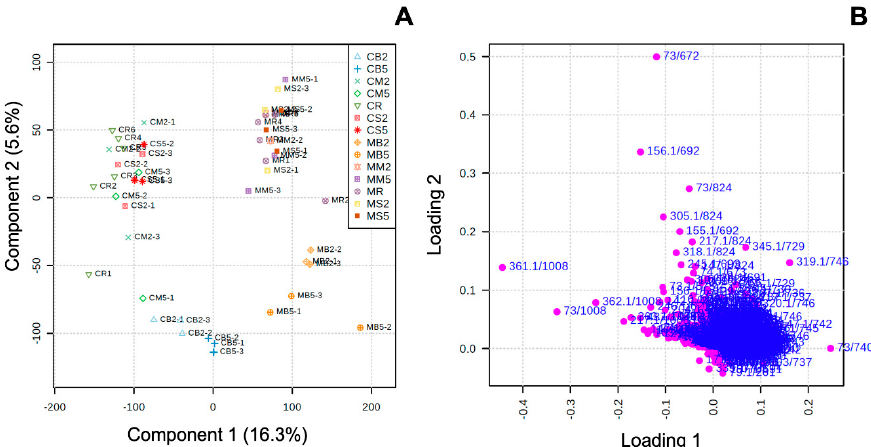
Figure 5. Partial least-square discrimination analysis score plot ( A ) and loading plot ( B ) derived from raw (control raw: CR; methyl jasmonate-treated raw: MR) and cooked control and methyl jasmonate- treated broccoli samples. The first letter, C or M, indicates the control or methyl jasmonate-treated group. The second letter, B, M, or S, indicates different cooking treatments including boiling, microwaving, and steaming. The last number after B, M, or S indicates the duration of the cooking method (mins). In the raw broccoli, MeJA treatment significantly reduced ( p ≤ 0.05) oxoproline, glutamic